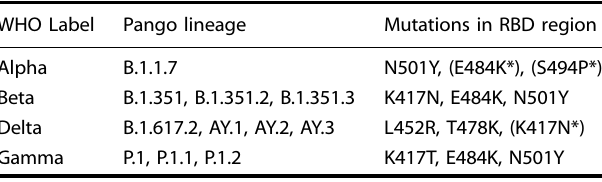
Table 3. Amino acid mutations in the RBD region of SARS-CoV-2 variants of